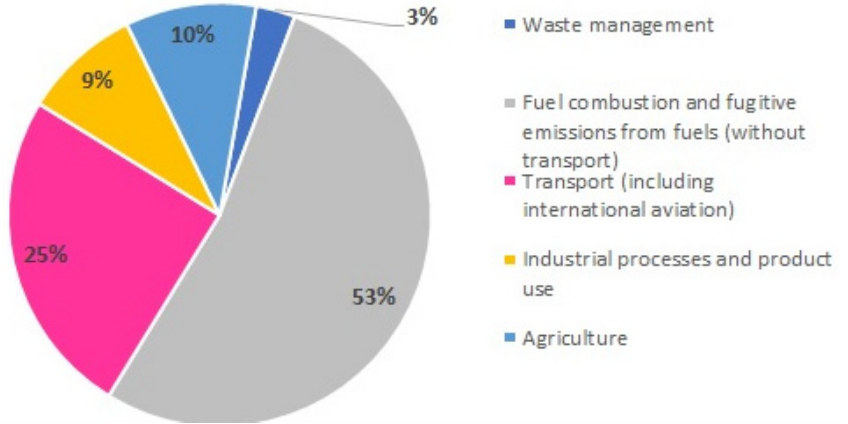
Figure 2. Greenhouse gas emissions, analysis by source sector, EU-27, 2018 (source: [4]).